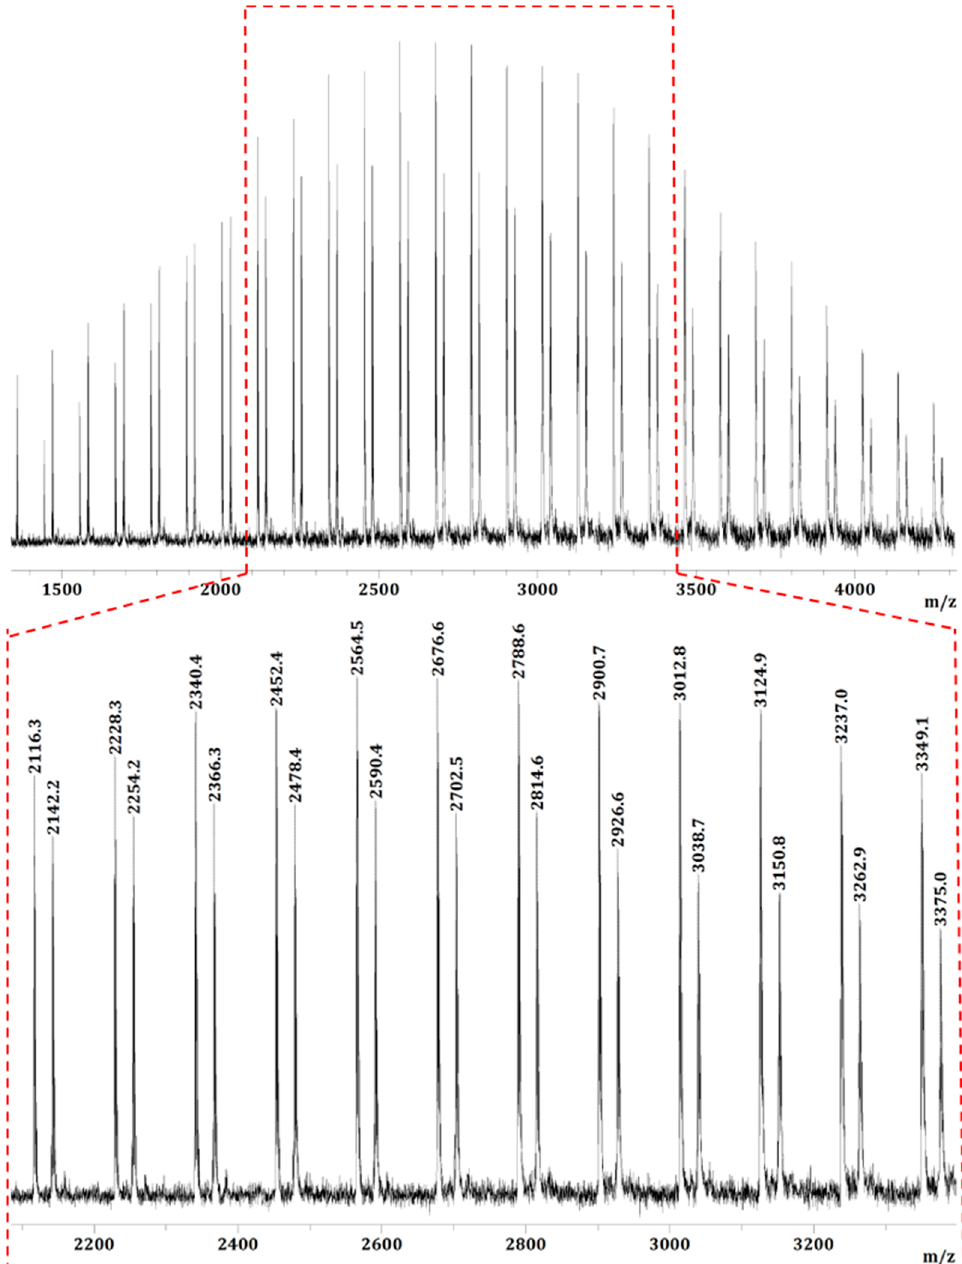
Figure 7. MALDI-TOF mass spectrum of the low-MW PMMBL sample produced by i Bu SKA/B(C 6 F 5 ) 3 in CH 2 Cl 2 at RT.